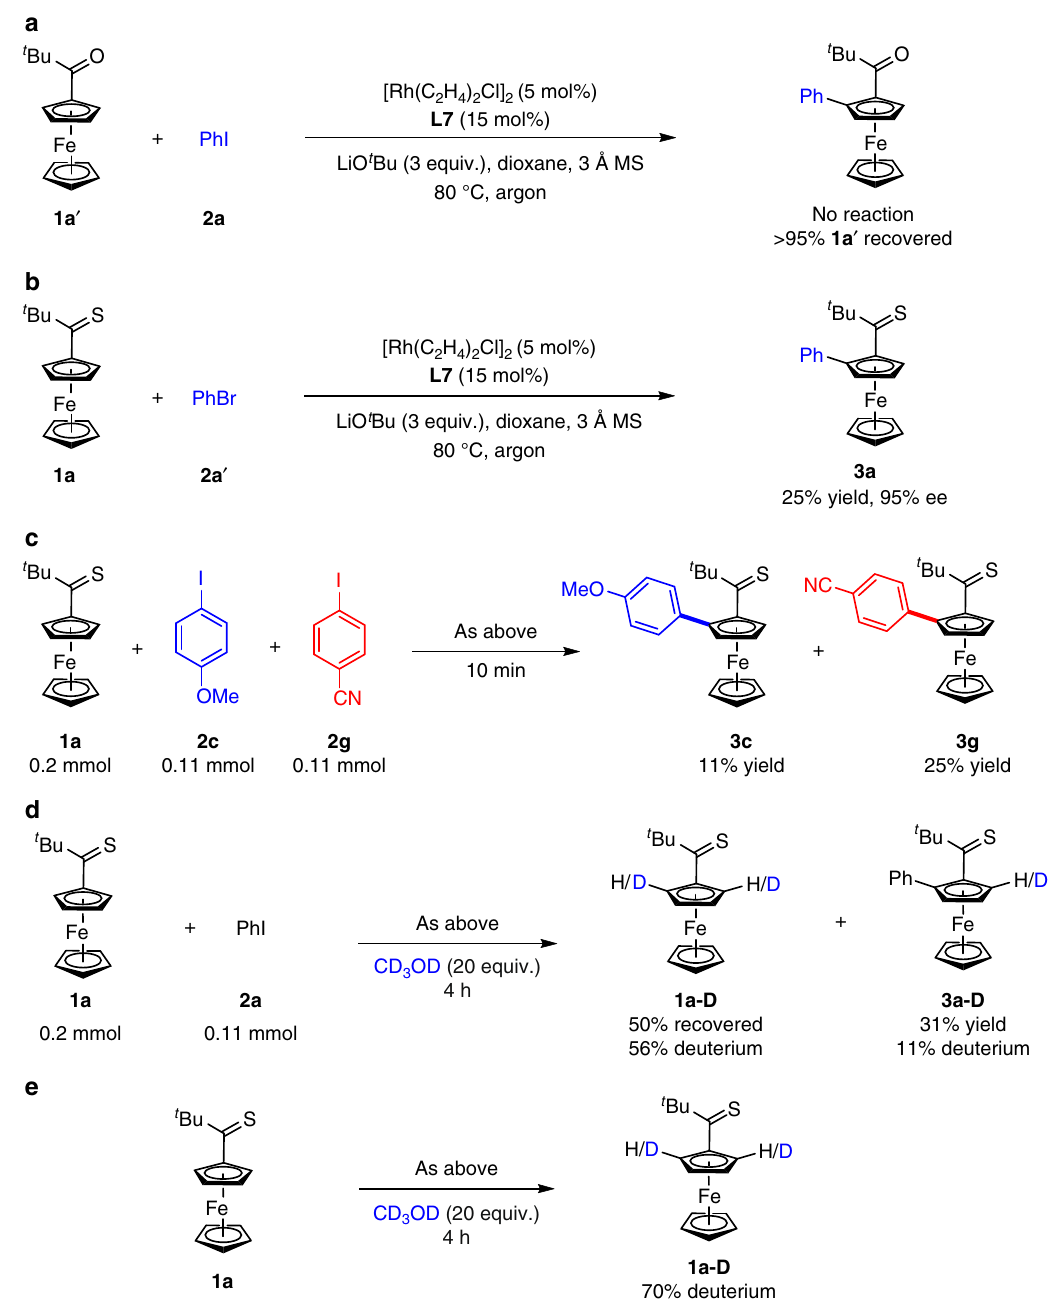
Fig. 3 Control experiments. a Arylation of carbonyl compound 1a ′ . b Bromobenzene was used as a coupling partner. c Competition experiment between 4-iodoanisole 2c and 4-iodobenzonitrile 2g . d H/D exchange experiment of 1a and 2a . e H/D exchange experiment of